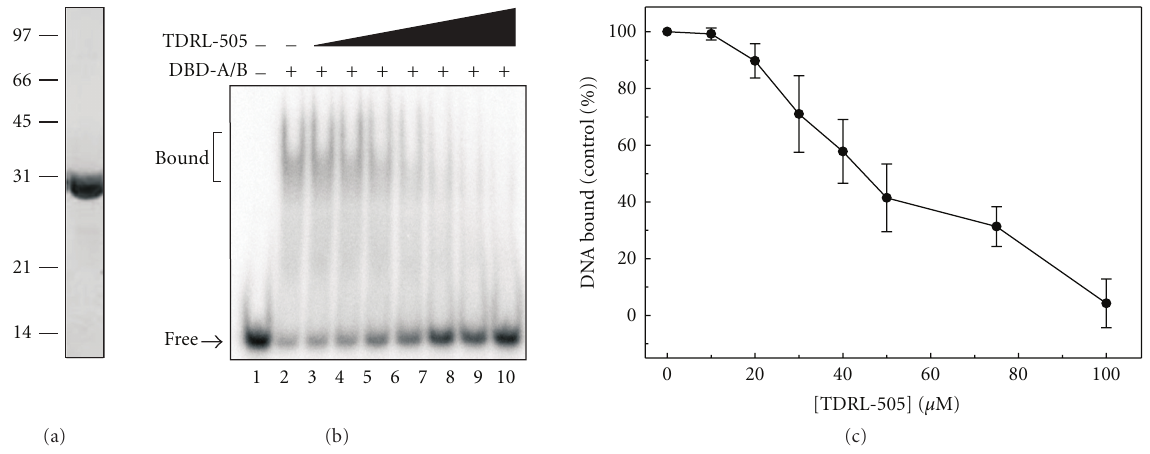
Figure 2: TDRL-505 inhibits RPA DBD-A/B-DNA interactions. (a) SDS-PAGE analysis of purified RPA DBD-A/B. DBD-A/B was purified as described in “Section 2” and analyzed by electrophoresis on a 12% NuPAGE Bis-Tris Gel. The gel was stained with Coomassie blue. (b) EMSA analysis of TDRL-505 inhibition of DBD-A/B DNA binding activity. Assays were performed as described in “Section 2” with increasing concentrations of TDRL-505 from 10–100 μ M in reactions with 12.5 nM DNA and 125 nM DBD-A/B. Products were analyzed by nondenaturing gel electrophoresis, dried, and imaged by phosphorimager analysis. The arrow indicates the position of the free DNA and the bracket the position of the bound DBD-A/B-DNA complex. (c) Quantification of EMSA binding data from Panel (b). The signal representing the RPA-bound and free fractions of DNA was quantified using ImageQuant software, and values represent the mean and SD of triplicate